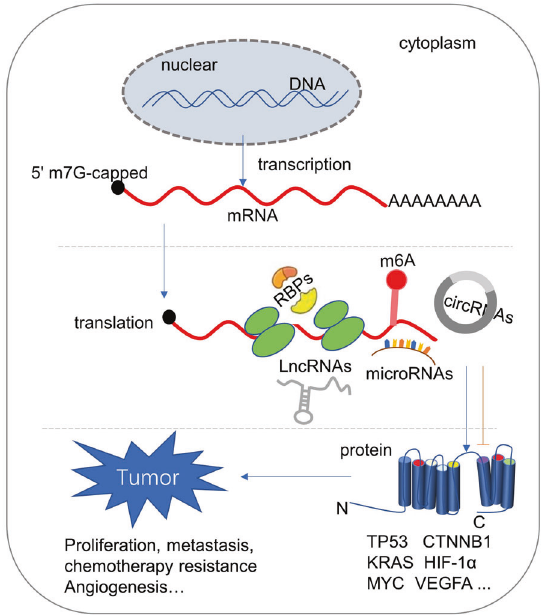
Fig. 1 The process of gene expression. Gene expression needs to be transcribed from DNA to RNA, translated into protein, and modi fi ed into mature protein to perform biological functions. This fi gure highlights the in fl uence of RBPs, microRNAs, lncRNAs, circRNAs, and RNA m6A modi fi cation on the protein translation procedure in tumorigenesis